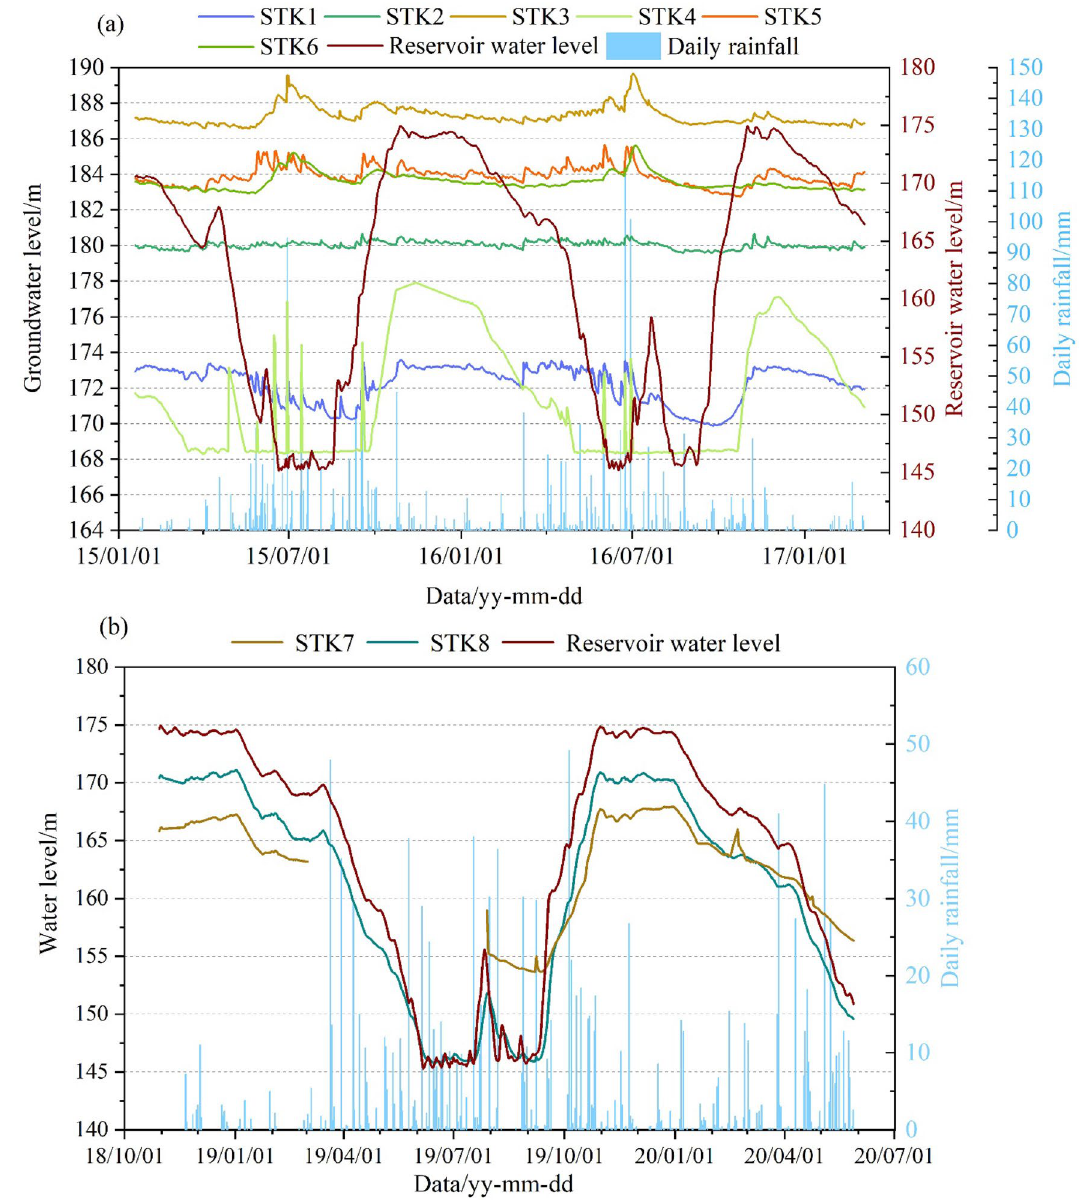
Figure 5. Monitoring plots of the groundwater level holes: ( a ) the semi-automatic groundwater level holes; ( b ) the automatic groundwater level